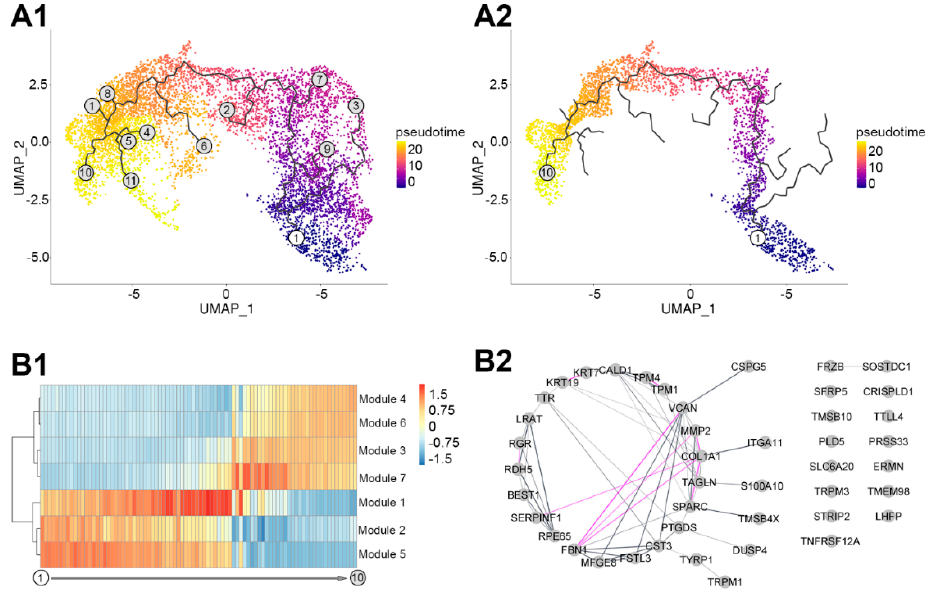
Figure 3. Dynamic changes of RPE over time in vitro. Identified trajectories ( A1 ) and the highlighted main trajectory ( A2 ) of in vitro RPE transcriptome over pseudotime (A, 0–20 represents pseudotime, node 1 corresponded to the less and node 10 to the more differentiated cells), heatmap visualization of the expression patterns the genes correlated with the main trajectory grouped into modules ( B1 , − 1.5–1.5 represents pseudotemporal expression), and network representation of the genes showing highest correlation with main trajectory of RPE culture pseudotime above the cut-off value of Moran I using Gene Analytics (( B2 ), grey lines represent validated connection via text mining, database information, and co-expression, pink lines represent experimentally validated network connection; the thickness of lines indicates the strength of data support).